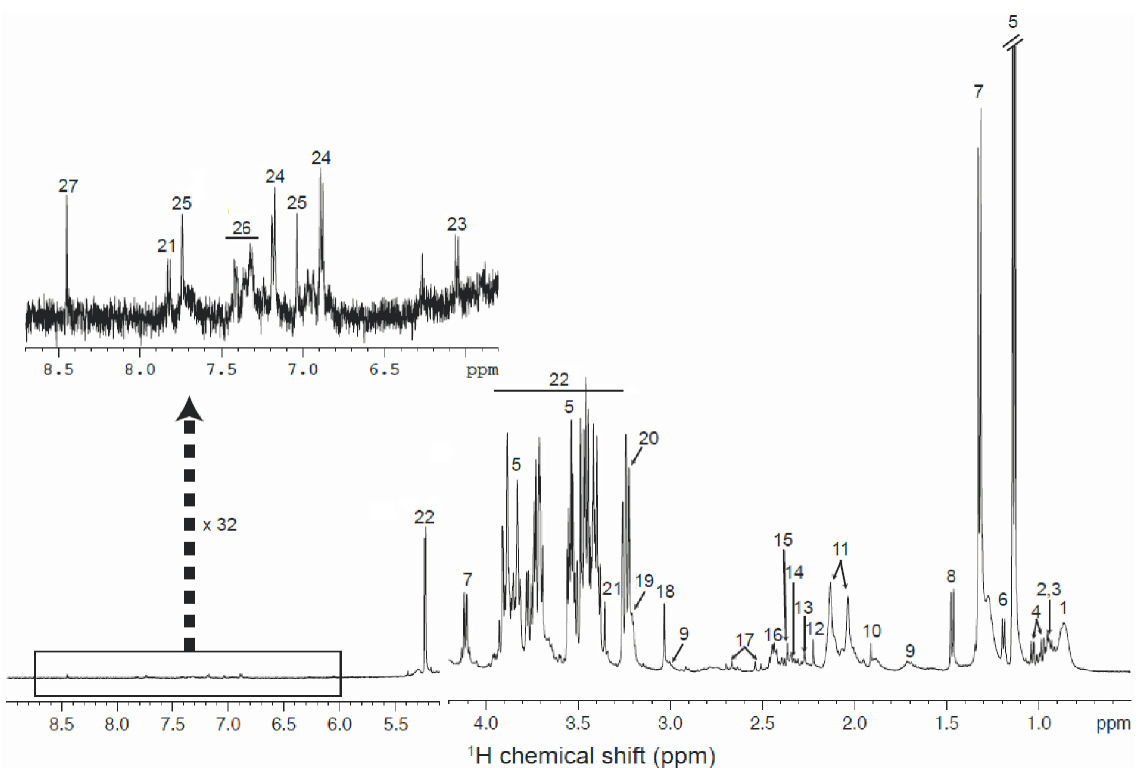
Fig 1. 1 H CPMG NMR spectrum of serum sample from rats fed with the HFS+C diet. Assignments: 1. lipids; 2. isoleucine; 3. leucine; 4. valine; 5. propylene glycol; 6. β -hydroxybutyrate; 7. lactate; 8. alanine; 9. lysine; 10. acetate; 11. glycoproteins (acetyl); 12. acetoacetate; 13. unknown; 14. glutamate; 15. pyruvate; 16. glutamine; 17. citrate; 18. creatine; 19. choline; 20. phosphocholine/glycerophosphocholine; 21. methanol; 22. alpha-glucose and beta- glucose; 23. cytidine; 24. tyrosine; 25. histidine; 26. phenylalanine; 27. formate.